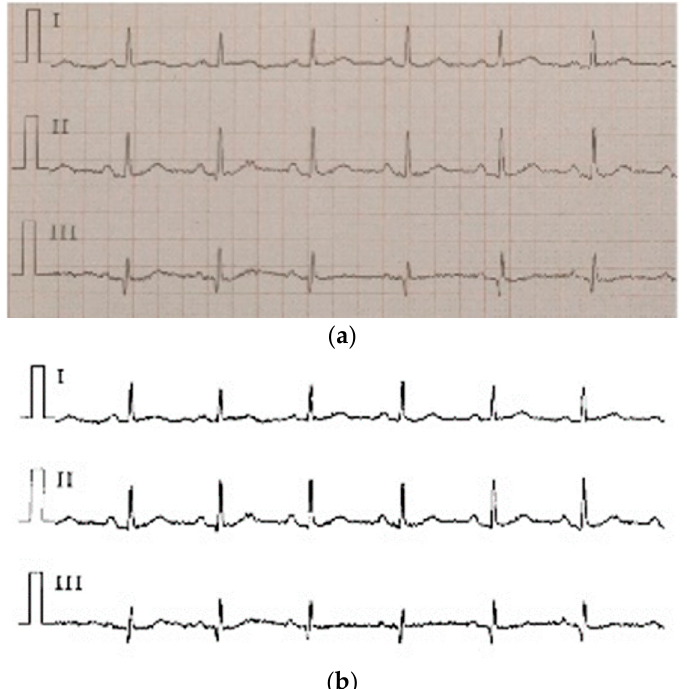
Figure 9. ( a ) the extracted image, ( b ) the original Holter image.